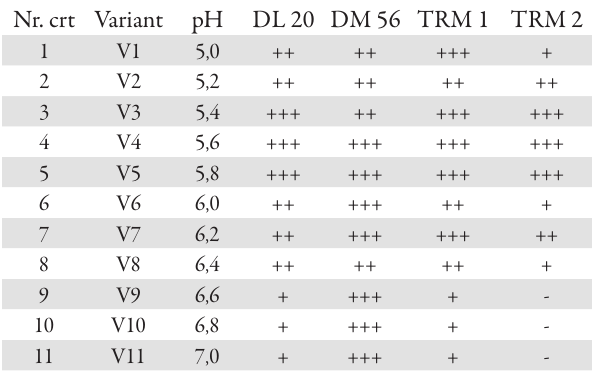
Tab. 1. The viability of microspores after 20 days of culture on media with different values of pH